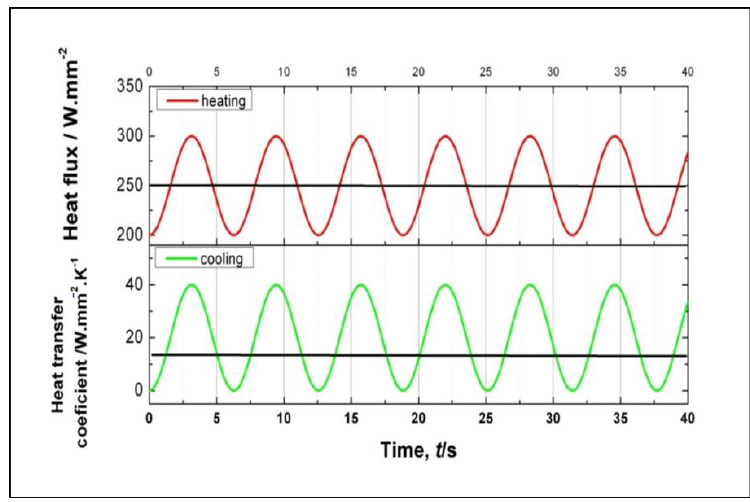
Figure 5. Various models of heating and cooling in time series.